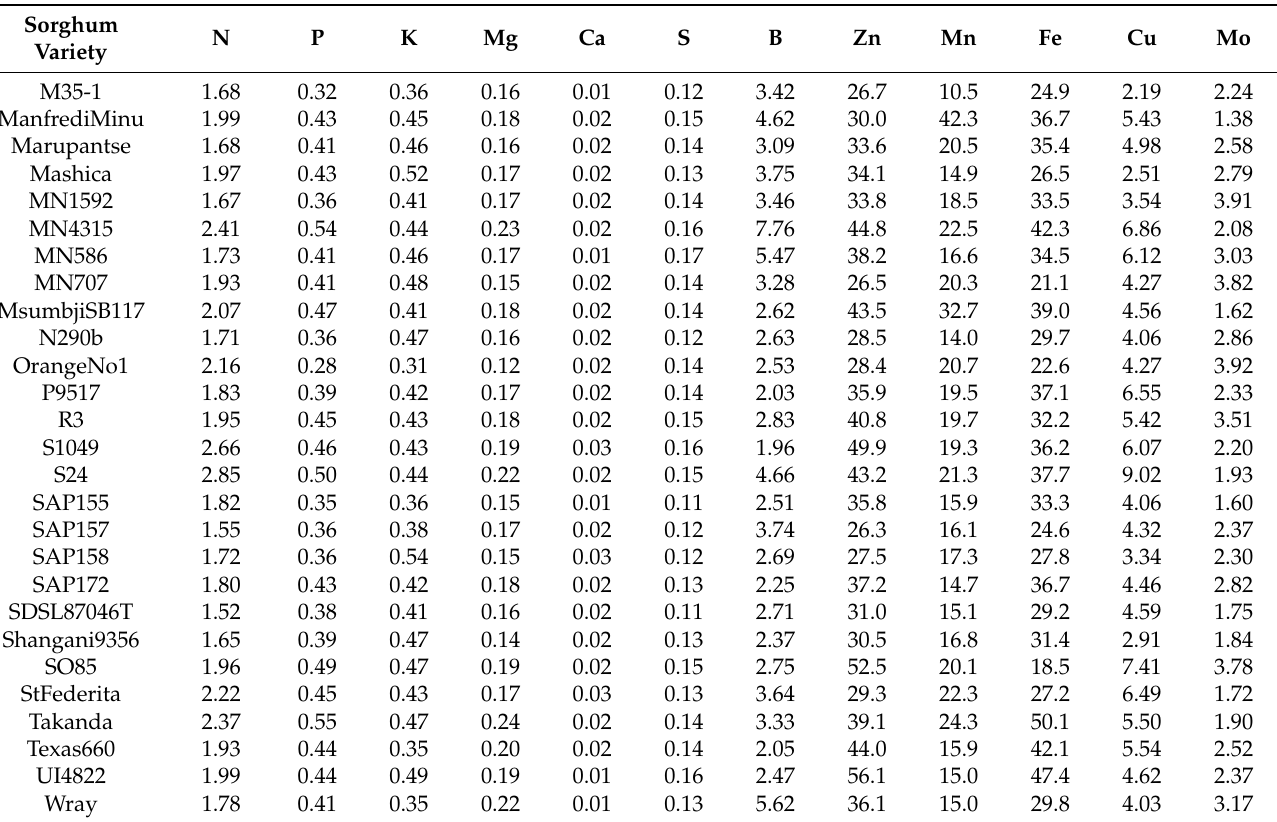
Figure 3. Selected correlations among seed elemental concentrations: ( A ) Flax P and Mg; ( B ) flax P and K; ( C ) sorghum P and Mg; ( D ) sorghum S and Mn; ( E ) sorghum large subset S and Mn; ( F ) sorghum Zn and Cu; ( G ) sorghum large subset Zn and Cu; ( H ) sorghum P and K. * and **, significant at the p < 0.05 and p < 0.01, respectively. NS, not significant, as determined using linear regression; R 2 , linear regression coefficient squared. 3.3. Nutritional Value of Flax and Sorghum Eight minerals were analyzed based on the United States Department of Agriculture (USDA) [16,17] recommended percentage daily value (% DV), which is a calculation of nutritional content in a 28 g (1 oz) serving of food and contribution to a 2000 calorie daily diet (USDA, 2020) [15]. As shown in Figure 4, daily consumption of 28 g of flax seeds could provide 37% DV of Cu, 31% DV of Mn, 28% DV of Mg, 19% DV of Zn, 19% DV of Zn, 18% DV of P, 11% DV of Fe, and 5% DV of Ca and K. Our analysis of sorghum showed that daily consumption of 28 g seeds could provide 24% DV of Mn, 16% DV of Cu, 11% DV of Mg, 10% DV of Zn, 9% DV of P, 7% DV of Fe, 4% DV of Ca, and 3% DV of K (Figure 4).